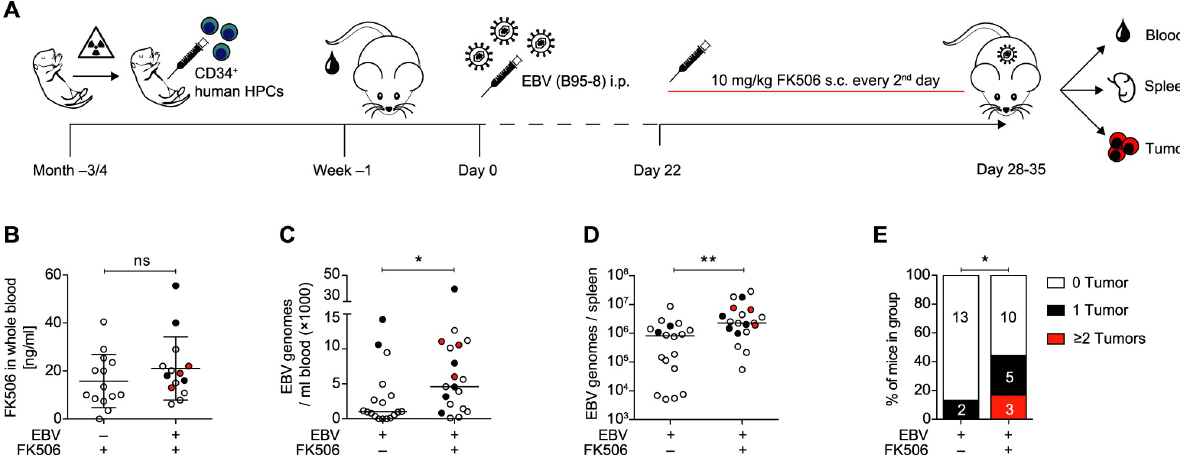
Fig 1. FK506 treatment of EBV-infected huNSG-A2 mice leads to a higher viral burden and more frequent tumor formation. A) Experimental set up of huNSG-A2 generation, infection and FK506 treatment. Upon irradiation, NSG-A2 mice received an intrahepatic injection of human CD34 + hematopoietic progenitor cells (HPCs). Reconstitution of human immune system components was assessed in peripheral blood three to four months later. Animals were then injected i.p. with 10 5 Raji infecting units (RIU) or PBS on day 0. Starting on day 22, animals were treated with FK506 (10mg/ kg body weight) or PBS every second day until termination of the experiment. B) FK506 concentration was measured 24h after subcutaneous (s.c.) administration of the compound mixture and after a minimum of three applications as described in A) . Concentration in whole blood (ng/ml) from individual mice from three independent experiments is depicted. Mean ± SD, p = 0.335 (Mann-Whitney test = MWT). C) Quantitative analysis of EBV DNA was performed by qPCR in duplicates for the amplification of BamHI W fragment of EBV in whole blood and D) in the spleen of mice that survived at least until day 28. DNA levels were measured at the day of sacrifice and are depicted from five pooled experiments (median, MWT). E) Percent of all mice per group with macroscopically visible, EBV-associated tumors, as confirmed via EBNA2 immunohistochemistry (IHC), from four independent experiments. Absolute numbers of mice are indicated per group (tumor score, MWT). B-D) Tumor presence in individual mice is indicated by symbol color: clear = no tumors, black = 1 tumor, red = 2 or more tumors. � : p < 0.05, �� : p < 0.01. See also S1 Fig.